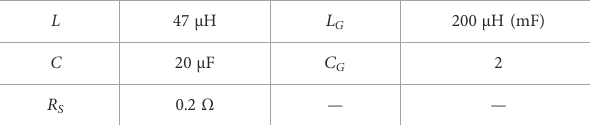
TABLE 3 Parameters used in DC-DC converter